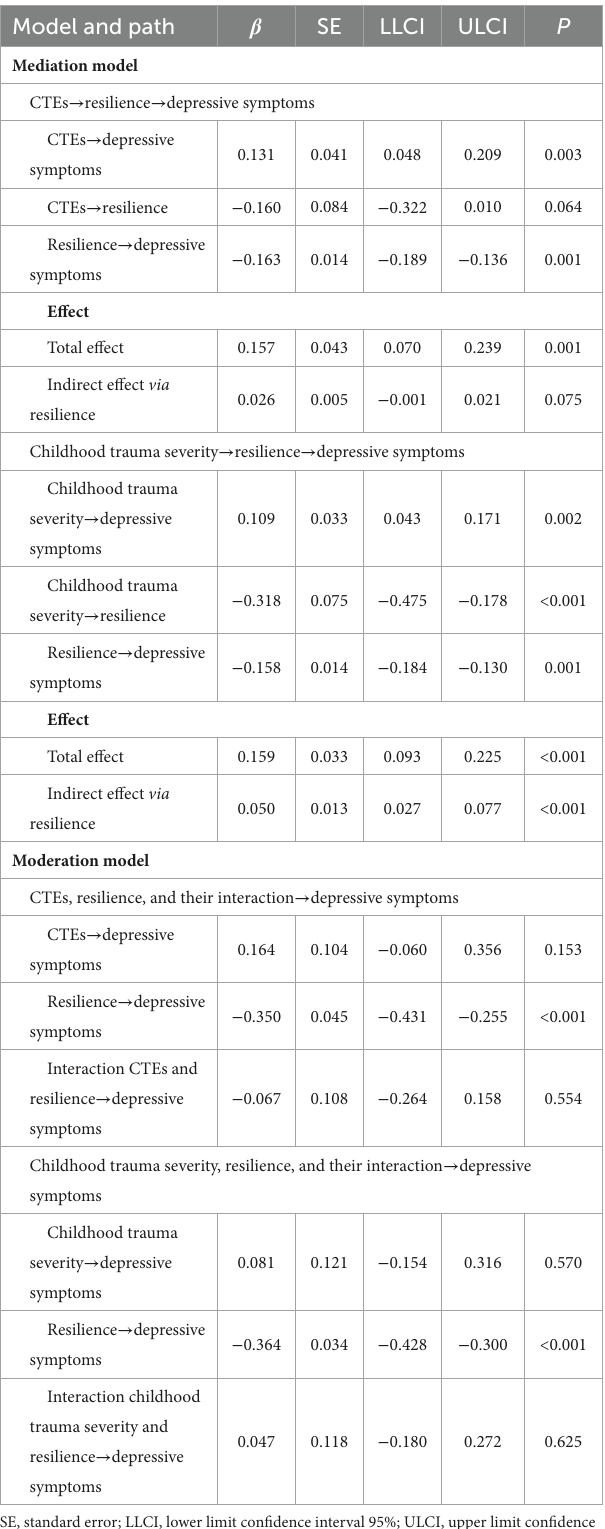
TABLE 3 Testing the mediating and moderating effects of resilience on the associations of childhood traumatic events (CTEs) and childhood trauma severity with geriatric depressive